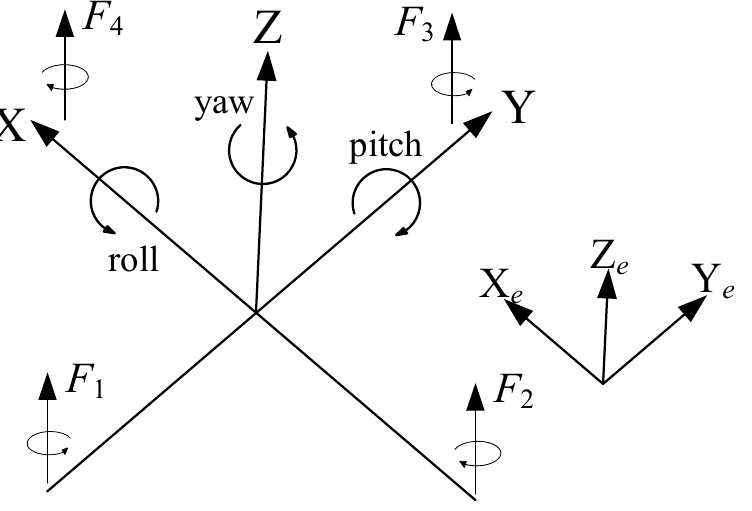
Figure 1. Quadrotor body coordinate system and ground coordinate